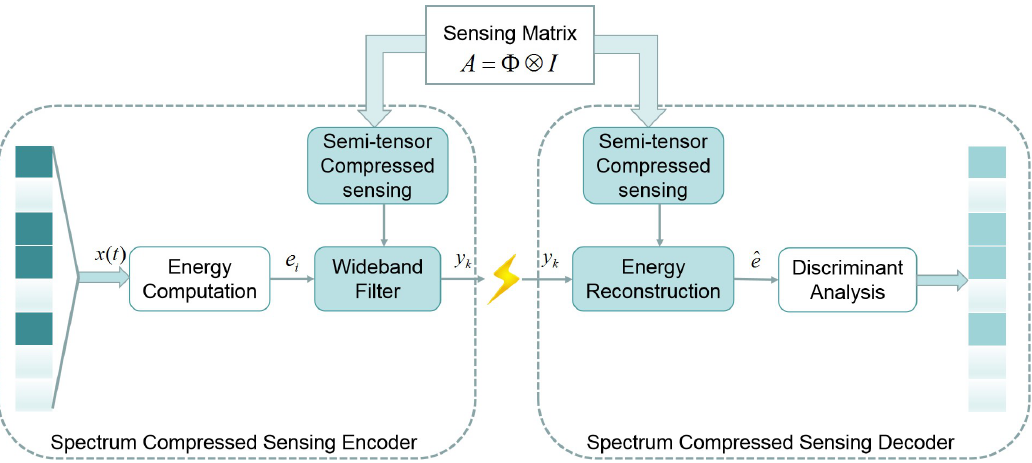
Figure 3. A scheme of semi-tensor product compressed spectrum sensing (STP-CSS). The channel energy is calculated and compressed in the encoder and reconstructed in the decoder to determine the occupancy of the spectrum